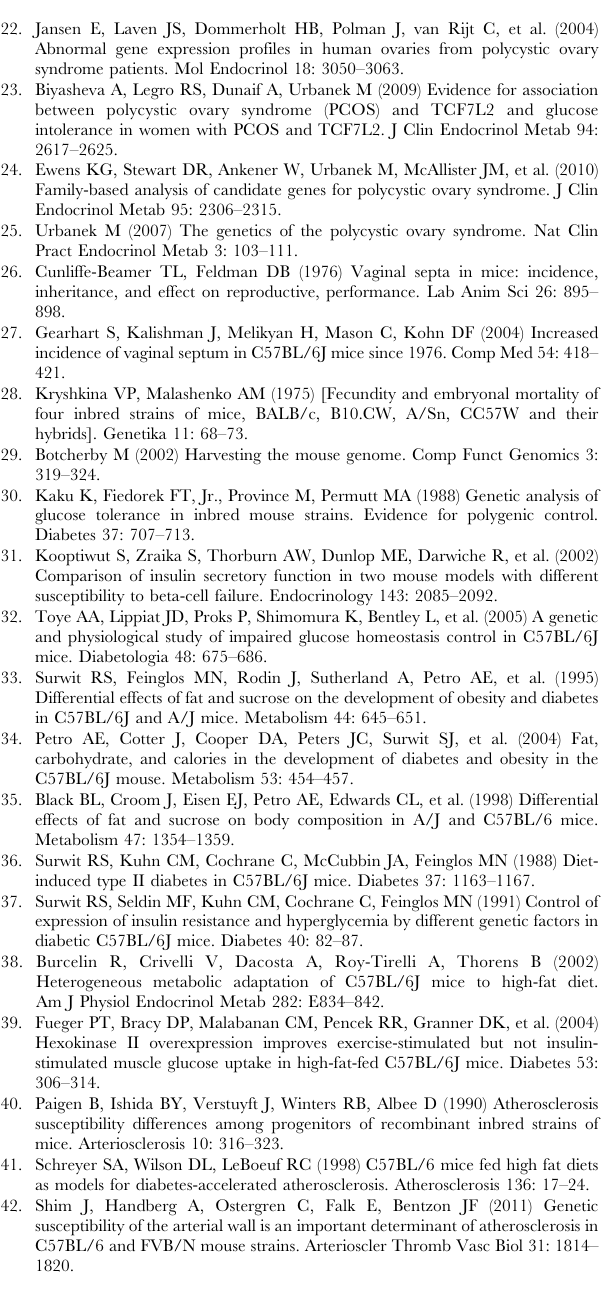
Table SI RT PCR primers used for gene expression